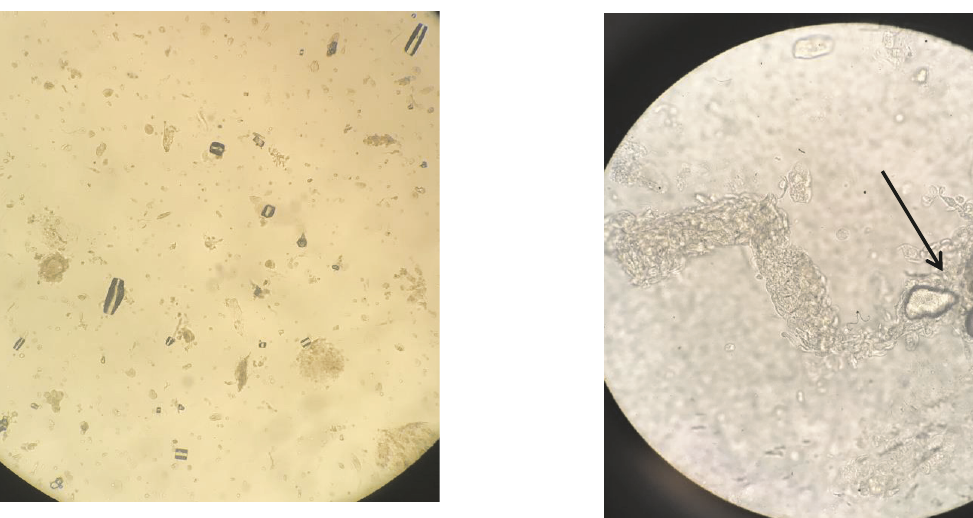
Figure 1: Urine microscopy under low power magnification show- ing uric acid crystals.